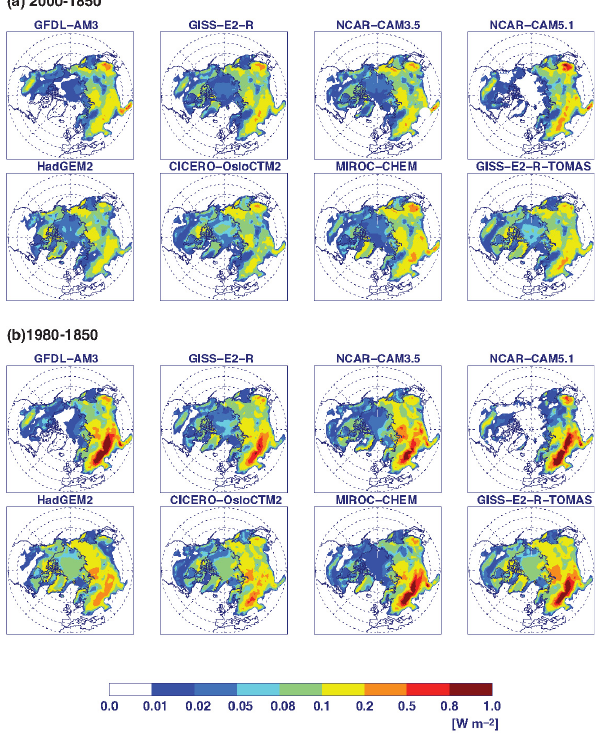
Fig. 16. Global distributions of the offline BC albedo forcing in (a) 2000 relative to 1850 and (b) 1980 relative to